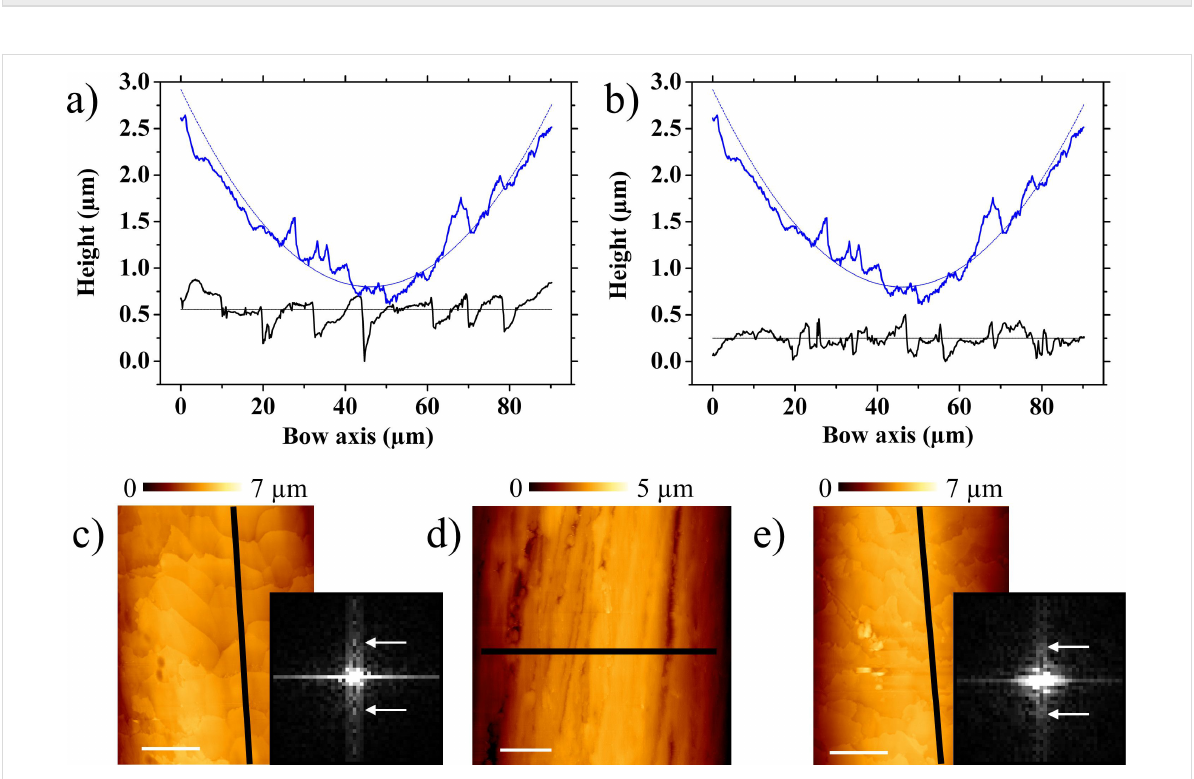
Figure 6: Line profile comparison between D-string (upper plots, blue line) and sample 1 (a) and 2 (b) surfaces (black lines). The horizontal lines are the average of the hair profiles, and the curved lines correspond to the section of a cylinder of the D-string diameter. (c–e) Profile extraction lines for sample 1 (c), the D-string (d), and sample 2 (e). Insets in pictures c and e are the 0.5 × 0.5 µm − 1 central areas of the corresponding two-dimensional fast Fourier transforms at the same intensity contrast. White arrows indicate frequencies associated with 9 µm vertical wavelengths in both cases. All white scale bars are 20